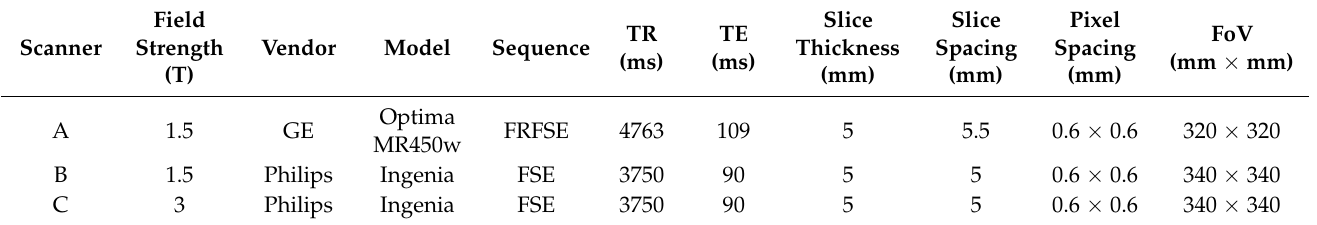
Table 1. Scanner properties and imaging parameters. TR = repetition time; TE = echo